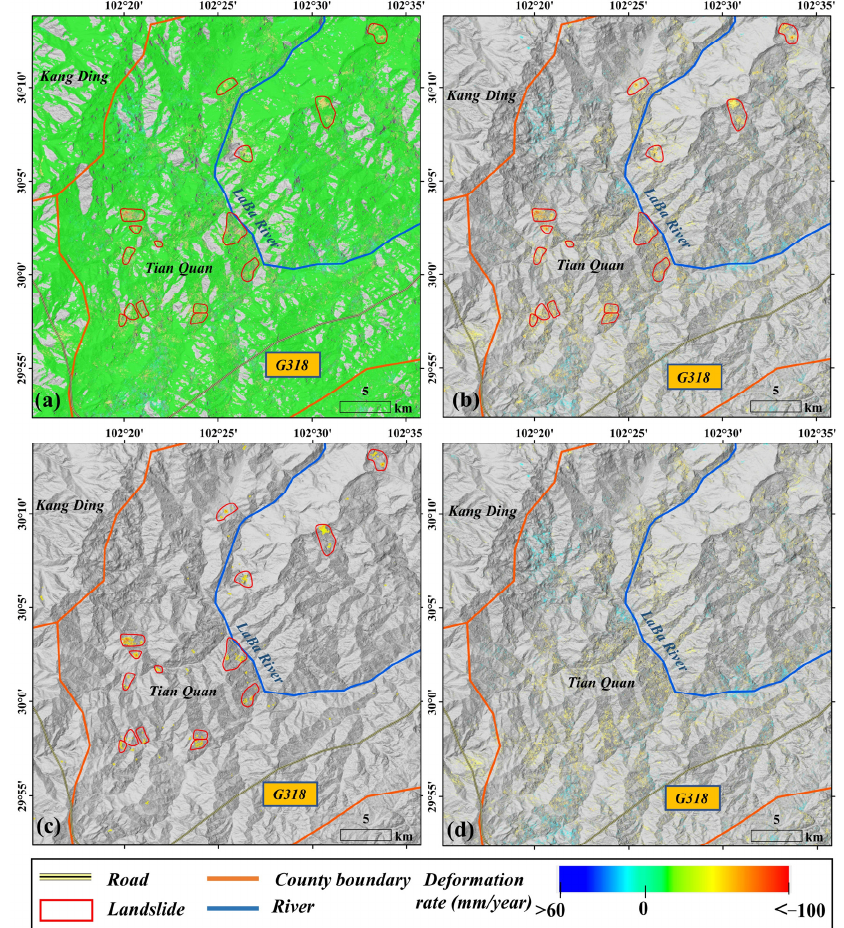
Figure 10. Comparison between original annual deformation rate map, stable region data removing results, and hot spot analysis results. ( a ) Original annual deformation rate. ( b ) Annual deformation rate map after removing data on stable region by considering deformation threshold. ( c ) Annual deformation rate map after hot spot analysis. ( d ) Error deformation area removed by hot spot analysis.